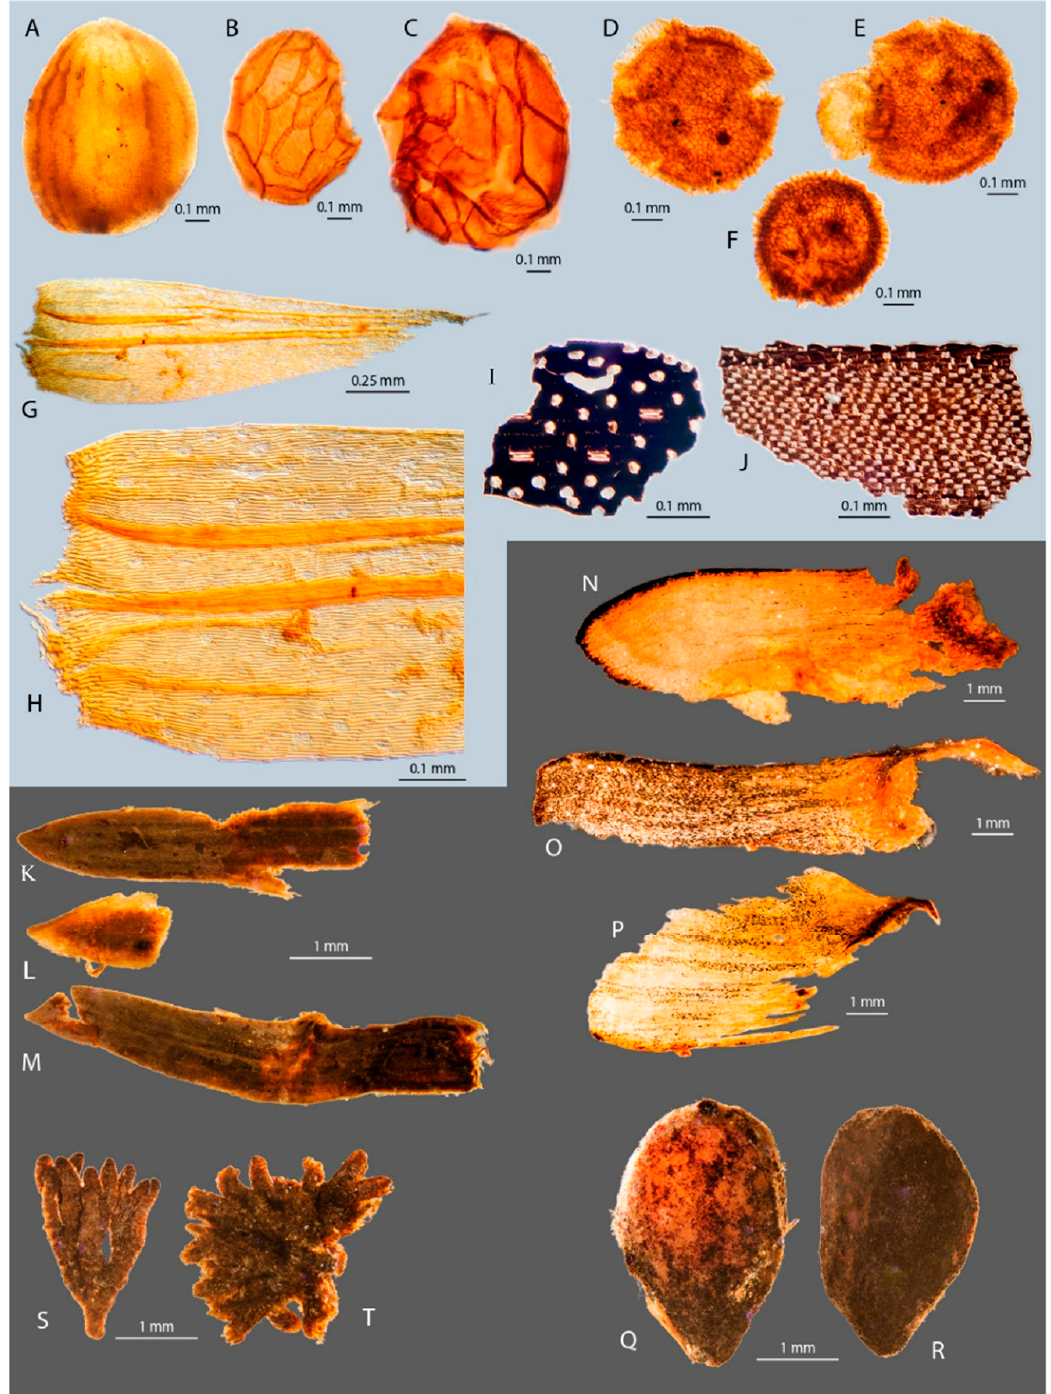
Figure 3. ( A ) Lemna spec., seed; ( B ) and ( C ) Hottonia palustris , seeds; ( D – F ) Utricularia spec., seeds; ( G ) and ( H ) Tomentypnum nitens , leaf; ( I ) and ( J ) charred epidermis fragments Poaceae; ( K – M ) Pinus sylvestris , needle fragments; ( N – P ) Pinus sylvestris , seed wing fragments; ( Q ) and ( R ) Pinus sylvestris , seeds; ( S ) and ( T ) Pinus sylvestris , mycorrhizal